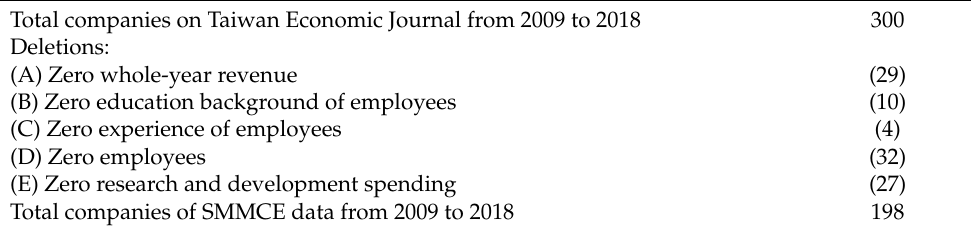
Table 1. Summary of the numbers of samples in the